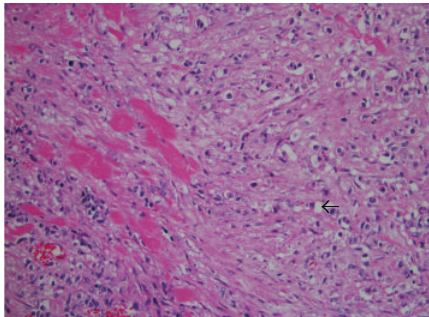
Figure 3: Fibroadipose tissue with infiltrating poorly di ff erentiated adenocarcinoma with signet-ring cell features (arrow), compatible with metastatic adenocarcinoma from known gastric adenocarci-